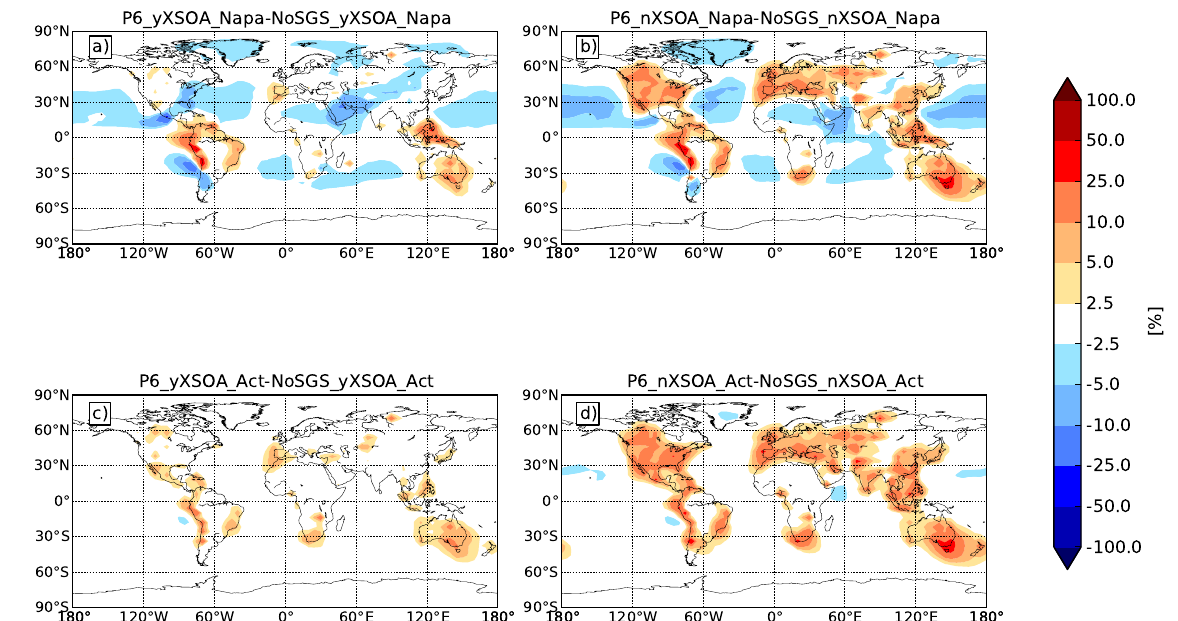
Figure 3. Change in annually averaged boundary-layer N80 between the P6 simulations and the NoSGS simulations for the (a) yX- SOA_Napa, (b) nXSOA_Napa, (c) yXSOA_Act, and (d) nXSOA_Act